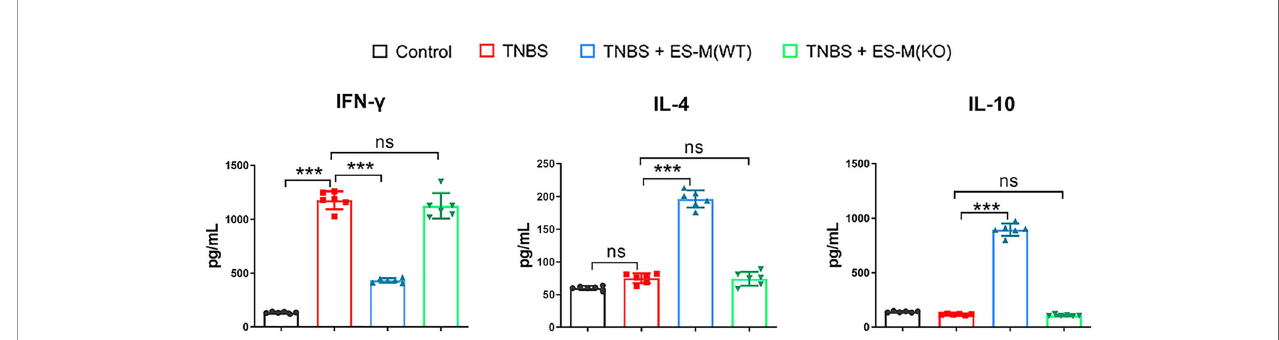
FIGURE 7 | Cytokine production in colons of T. spiralis ES – induced wild type (WT) or Nrf2 KO macrophages (ES-M) on TNBS-induced colitis. The colon culture supernatant was used to determine the cytokine production. IFN- g , IL-4 and IL-10 levels were measured by ELISA. Data are shown as the means ± SD (three independent experiments) of each group (n=6). ***p < 0.001, ns, no signi fi cance, as indicated by line (one-way ANOVA with Tukey ’